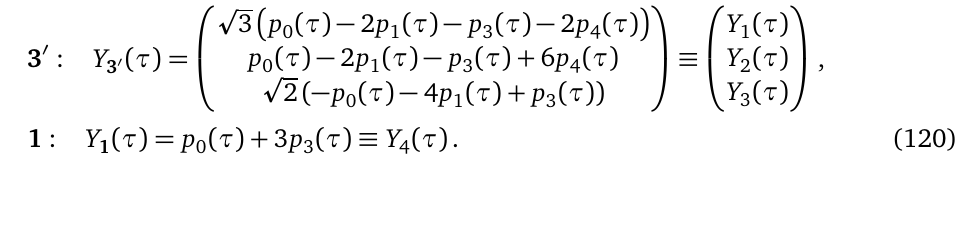
Table 3: The Kronecker products and Clebsch-Gordan coefficients of the S